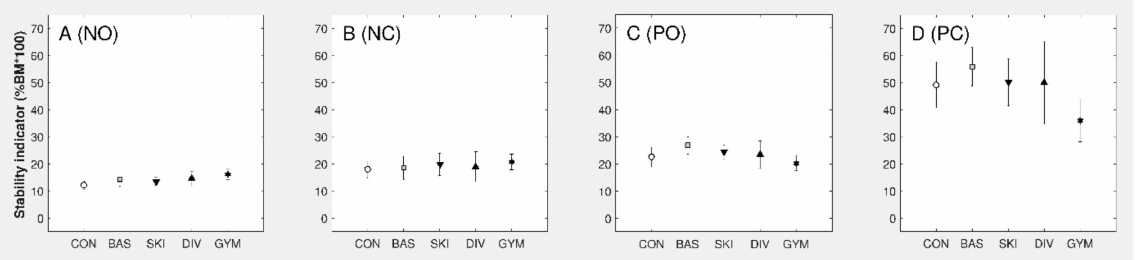
Figure 2. Parameter stability indicator (ST) for different sports in positions NO ( A ), NC ( B ), PO ( C ), and PC ( D ). CON— recreational athletes, BAS—Basketball, SKI—Ski Jumping, DIV—Diving, GYM—Gymnastics. Values are given as mean and standard